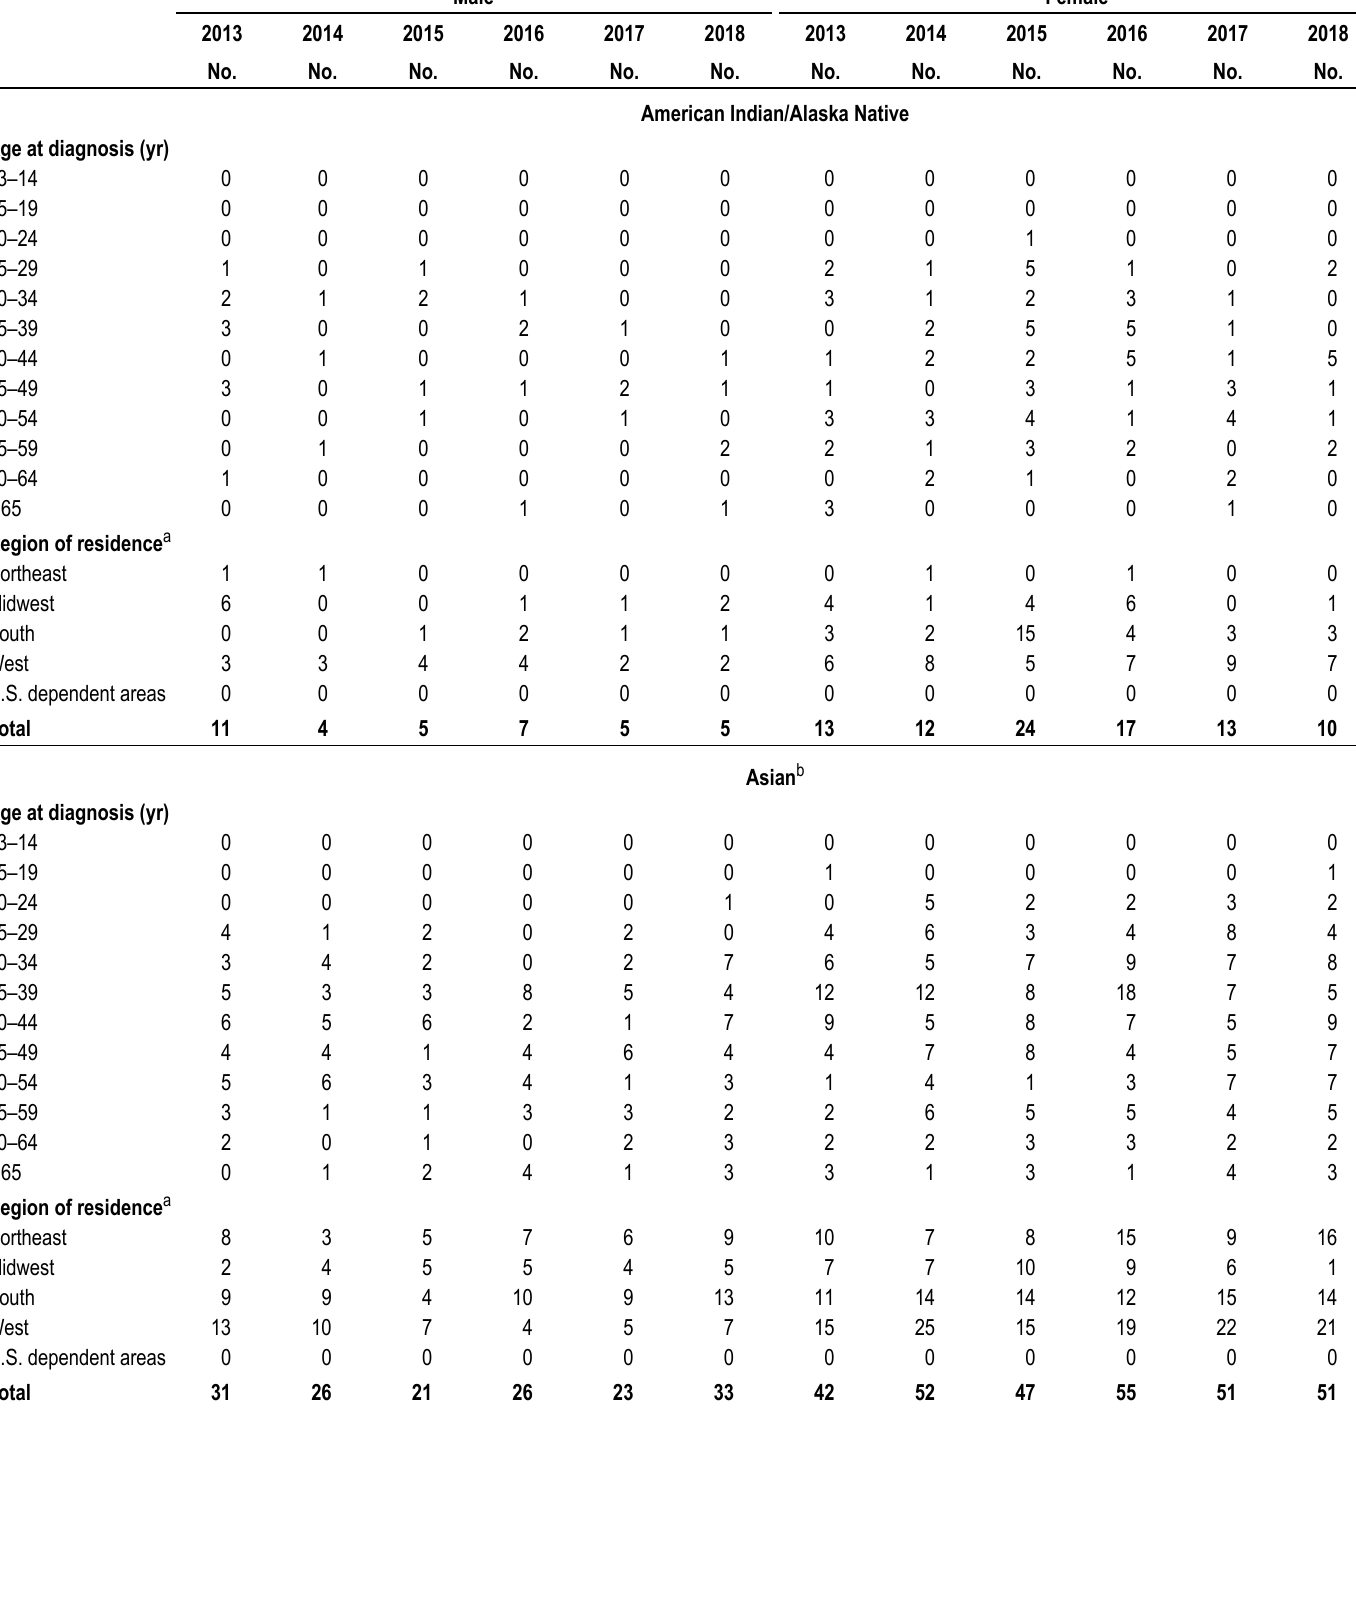
Table 12b. Stage 3 (AIDS) attributed to heterosexual contact, by selected characteristics, 2013–2018—United States and 6 dependent areas